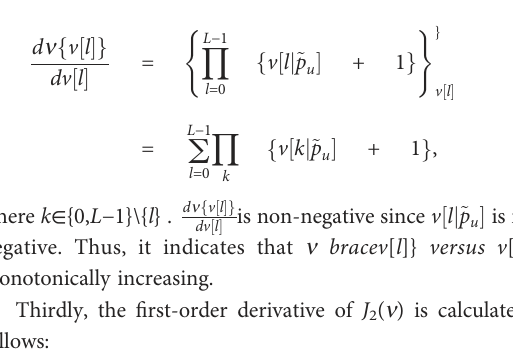
kept. The deep null level of J 2 ½ n ( ~ p u ) (cid:2) at the unmatched phase is bene fi cial to fi nd the optimal coef fi cients and suppress the i.i.d. noise. Since J 2 ½ n ( ~ p u ) (cid:2) is convex, any gradient algorithm can be used to solve this maximization